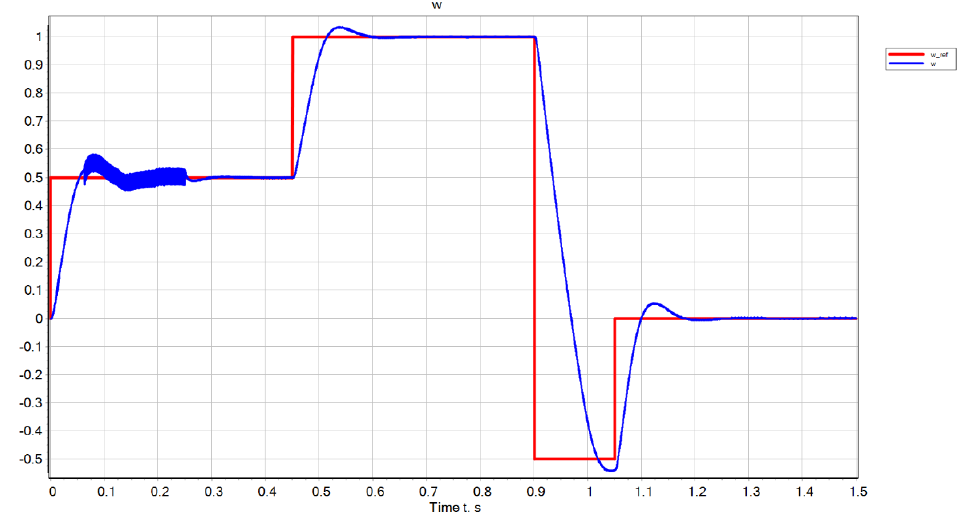
Figure 5. Set angular velocity and angular velocity of the motor at a load moment of inertia of 2.1 kg ∙ m 2